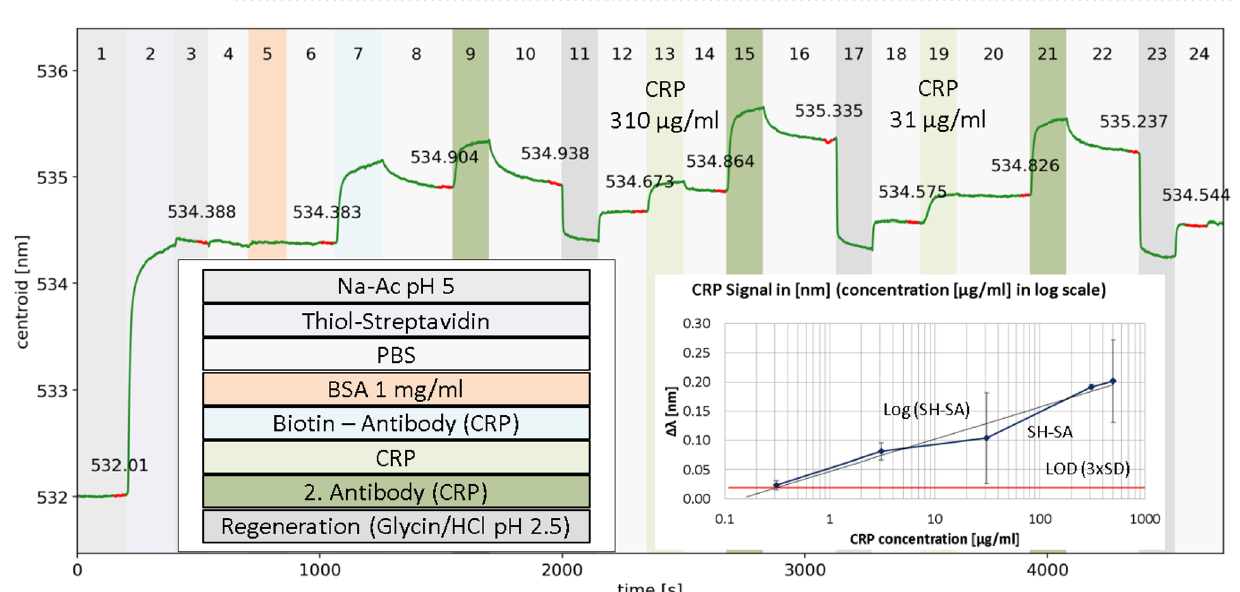
Figure 2. PAH/PSS bilayers realized by layer-by-layer (LbL) deposition. Plasmon shift (Δλ) in nm for each bilayer plotted against the number of PAH/PSS bilayer deposited on 80 nm spherical gold nano-particle sensors. The first two to three bilayers layers (unfilled squares) are known to be improperly formed 34 . Inset: Original sensogram plotting the LSPR response (peak wavelength) against time. Blue = 0.1 M NaCl, ivory = 1 mM PAH and purple = 1 mM PSS.